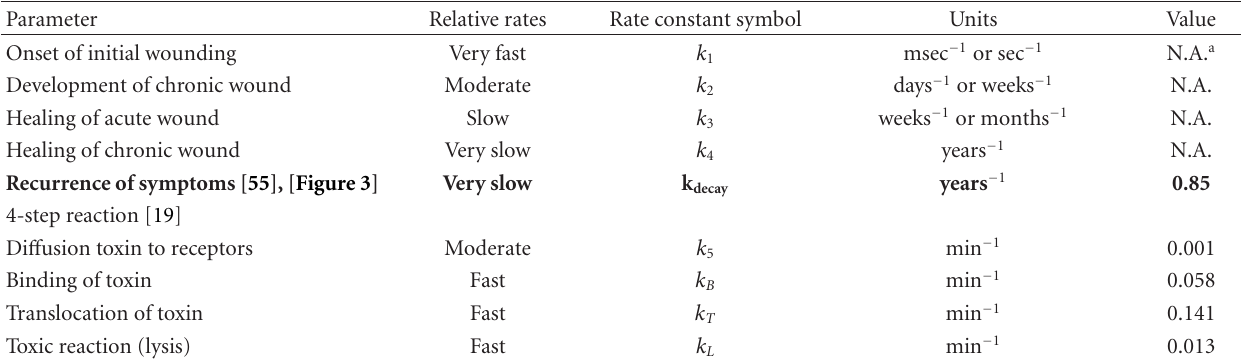
Table 1: Summary of processes involved in wound healing as described in text. Recurrence of symptoms results from long-term observations [55] was analyzed in the present paper and is highlighted in bold.